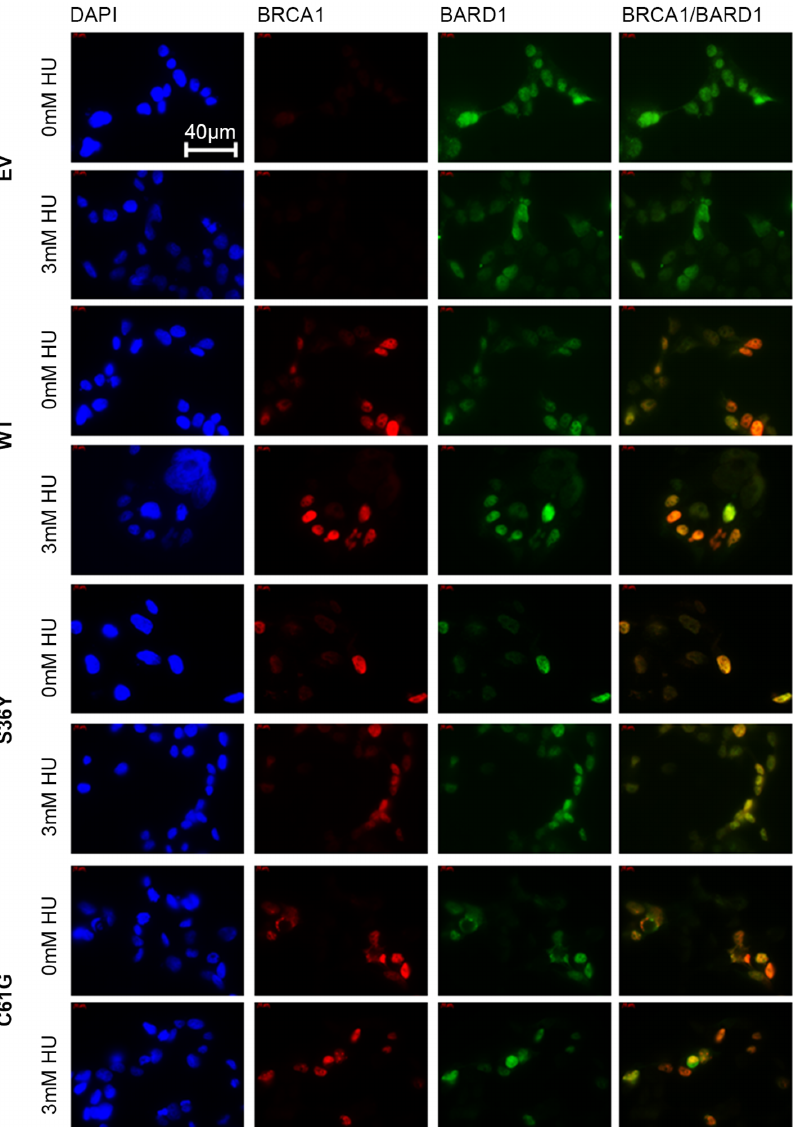
Figure 3. BRCA1 co-localizes with BARD1 in co-transfected HEK293T cells. Immunofluorescence analysis of transfected, S-phase synchronized cells following treatment with HU, demonstrated that the BRCA1 variants p.Ser36Tyr (S36Y) and p.Cys61Gly (C61G) exhibit lower expression levels in the nuclei of transfected cells in comparison to wild type (WT) transfected cells. However, neither of them lost the ability to co- localize with BARD1 in both HU untreated or treated cells. Nuclei were stained with DAPI (blue). When the pictures are merged, where green and red signal overlap a yellow signal is seen indicating co-localization. The results are representative of 3 experiments. Scale bar: 40 m m